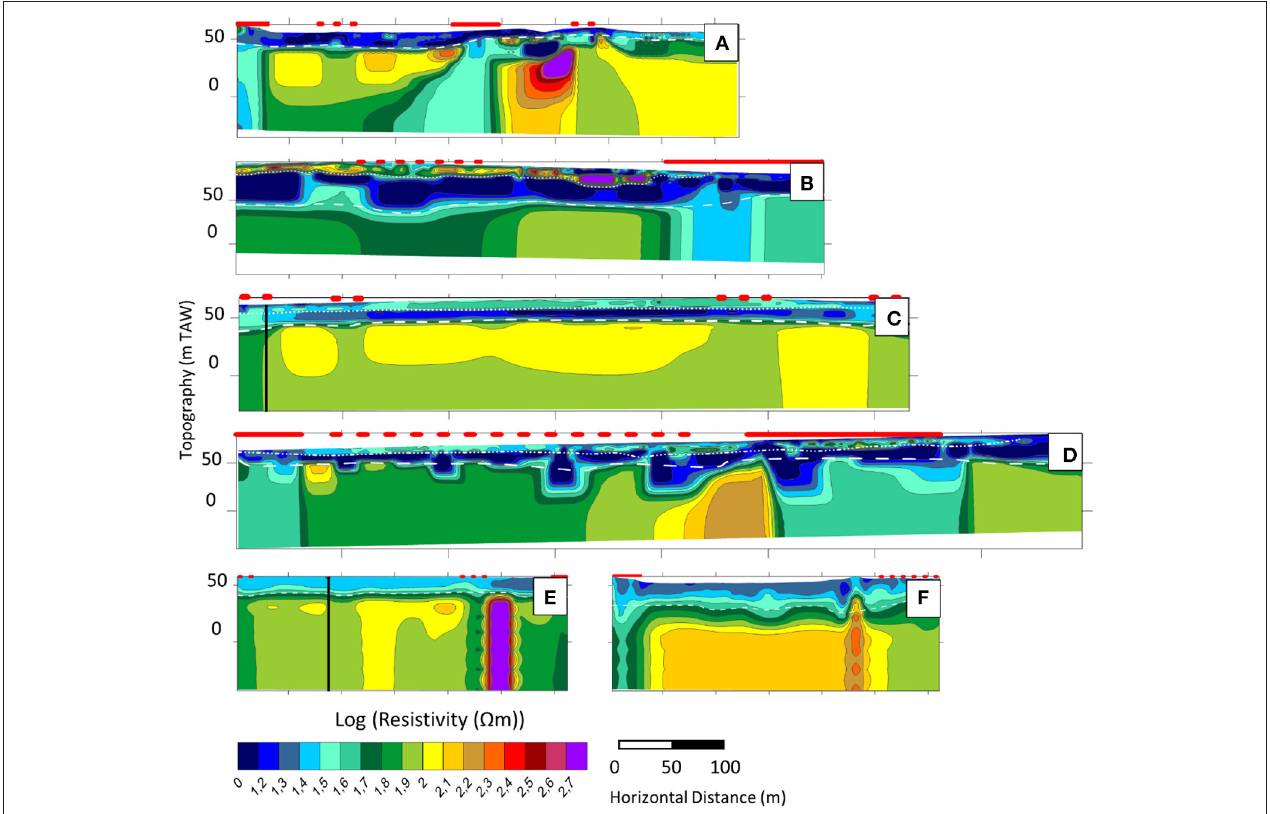
FIGURE 4 | Inversion results with fracture interpretation of profile 1 to 6 (A–F) . The full red line shows interpreted fractured zone, dotted red line indicate possible fracture zones. The white dash line indicates the top of the Cretaceous chalk layer and the full white line the bottom of the Quaternary